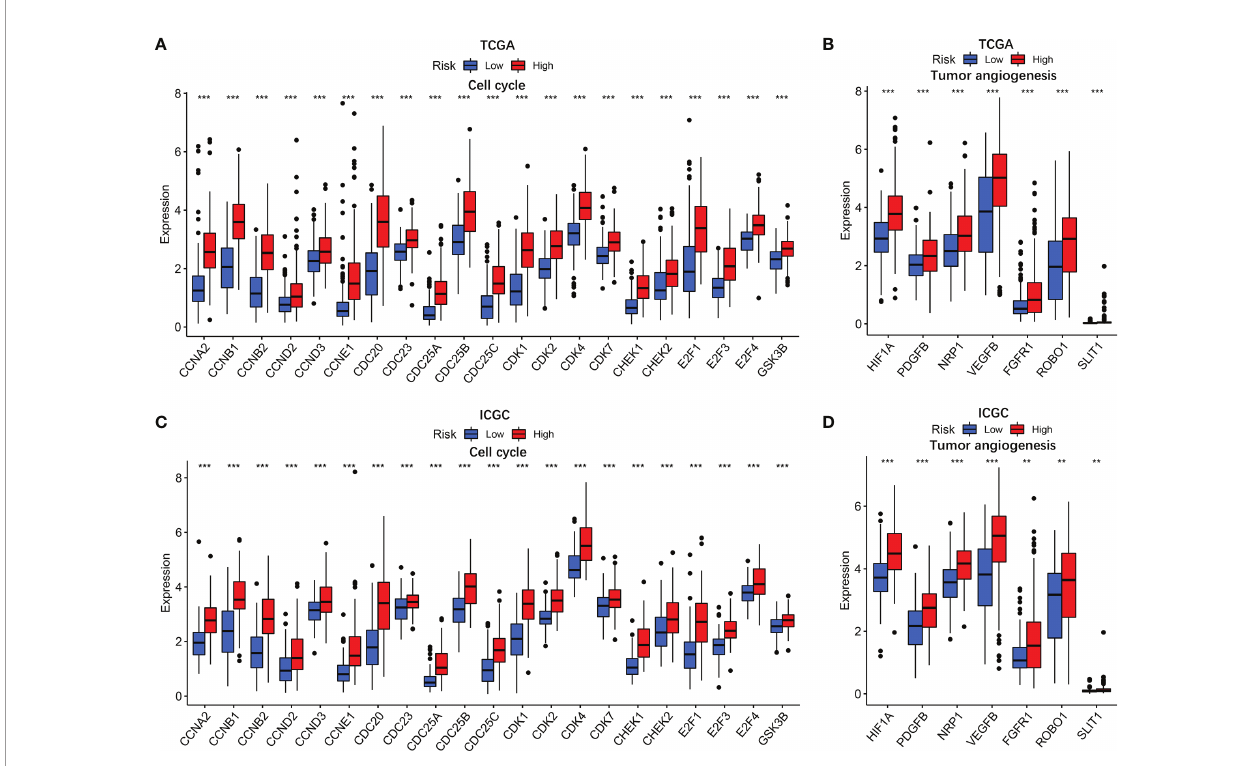
FIGURE 8 | The associations of risk score with cell cycle genes and tumor angiogenesis genes. TCGA cohort (A, B) and ICGC cohort (C, D) . P values were showed as: ns, not signi fi cant; *P < 0.05; **P < 0.01; ***P < 0.001.